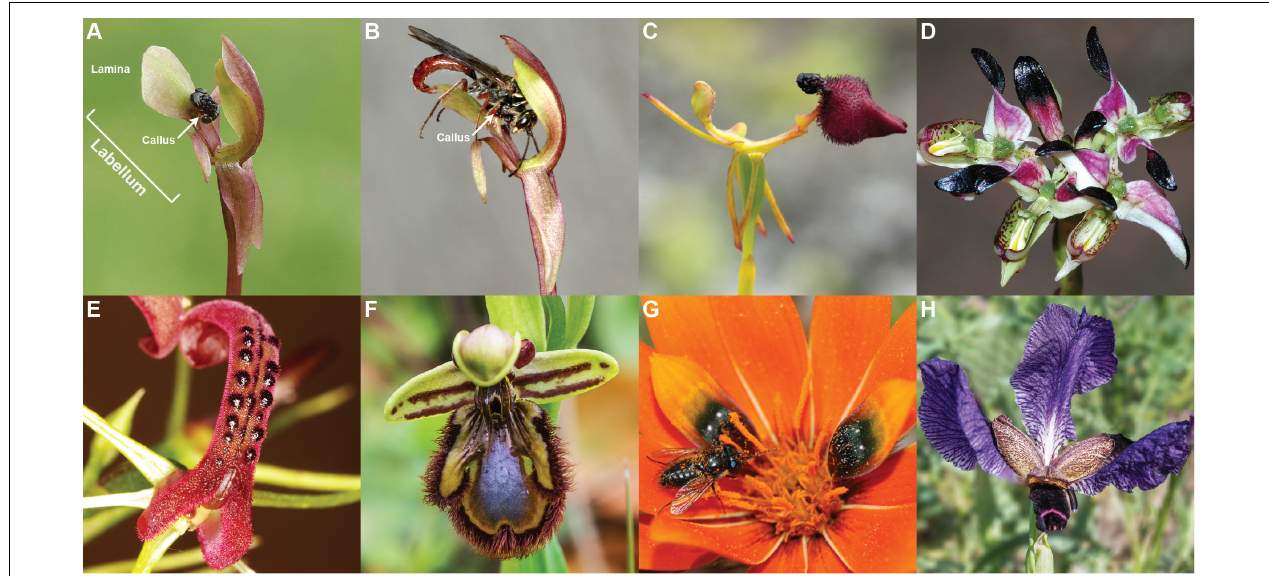
FIGURE 1 | An illustration of the diversity of sexually deceptive orchid and non-orchid species. Orchids: (A) The floral structure of Chiloglottis trapeziformis with (B) its male pollinator Neozeleboria cryptoides . The arrows point to the very dark, three dimensional “callus” structure on the dull green and red labellum lamina of Chiloglottis trapeziformis , (C) Drakaea glyptodon , (D) Disa atricapilla , (E) Cryptostylis leptochila , and (F) Ophrys speculum . Non-orchids: (G) Gorteria diffusa , and (H) Iris paradoxa . All images have been reproduced with permission from the respective copyright holders. Please refer to the Section “Acknowledgments” for image